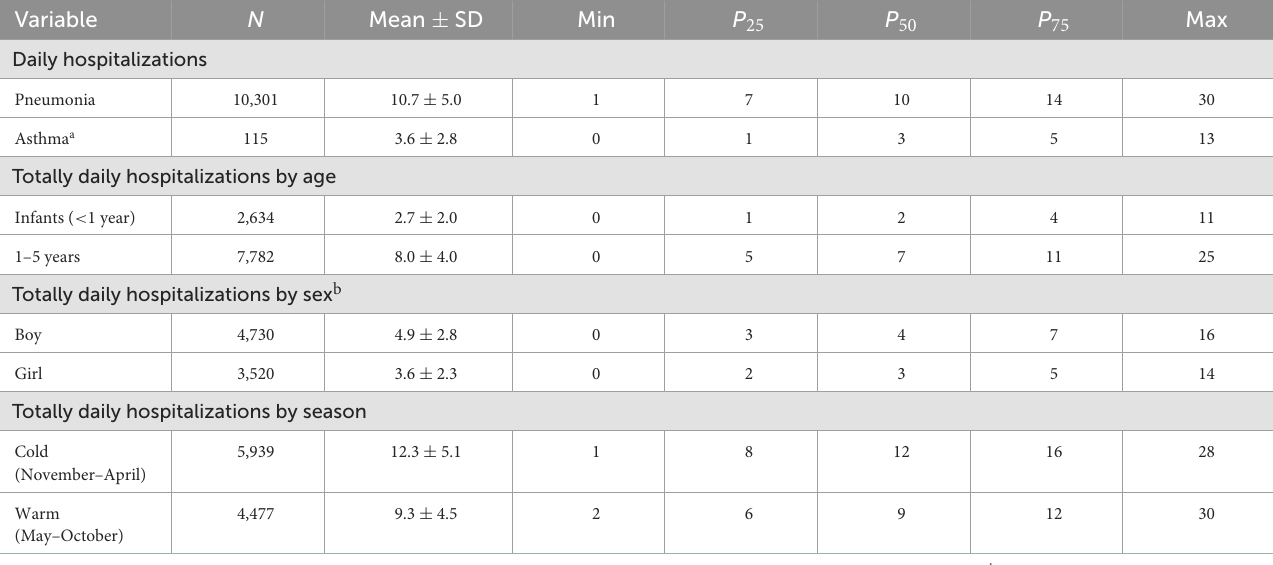
TABLE 1 Descriptive statistics of the hospitalization for pneumonia and asthma among children aged < 5 years, Ningbo City, 2015–2017. Variable N Daily